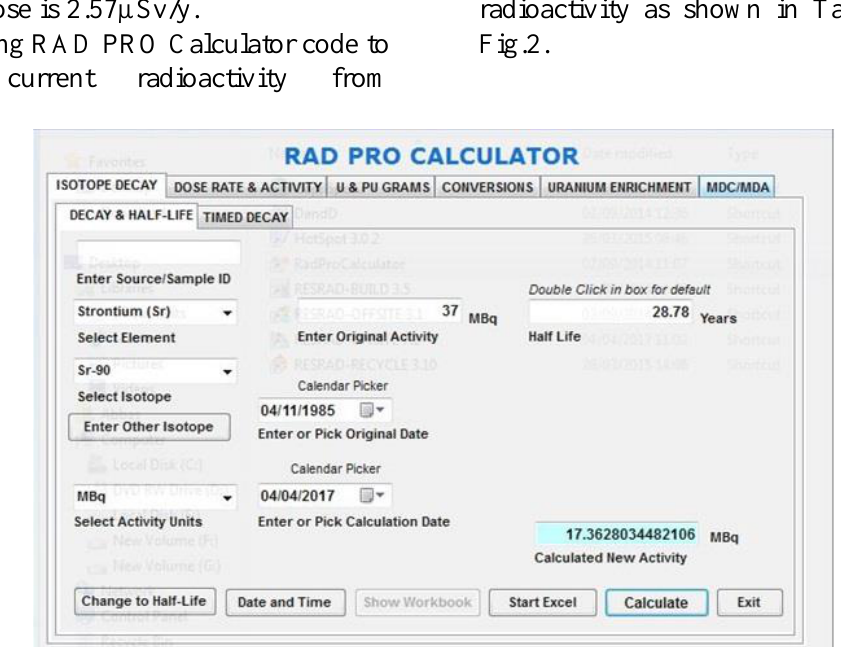
Fig.2: Calculation of current activity for Sr-90.